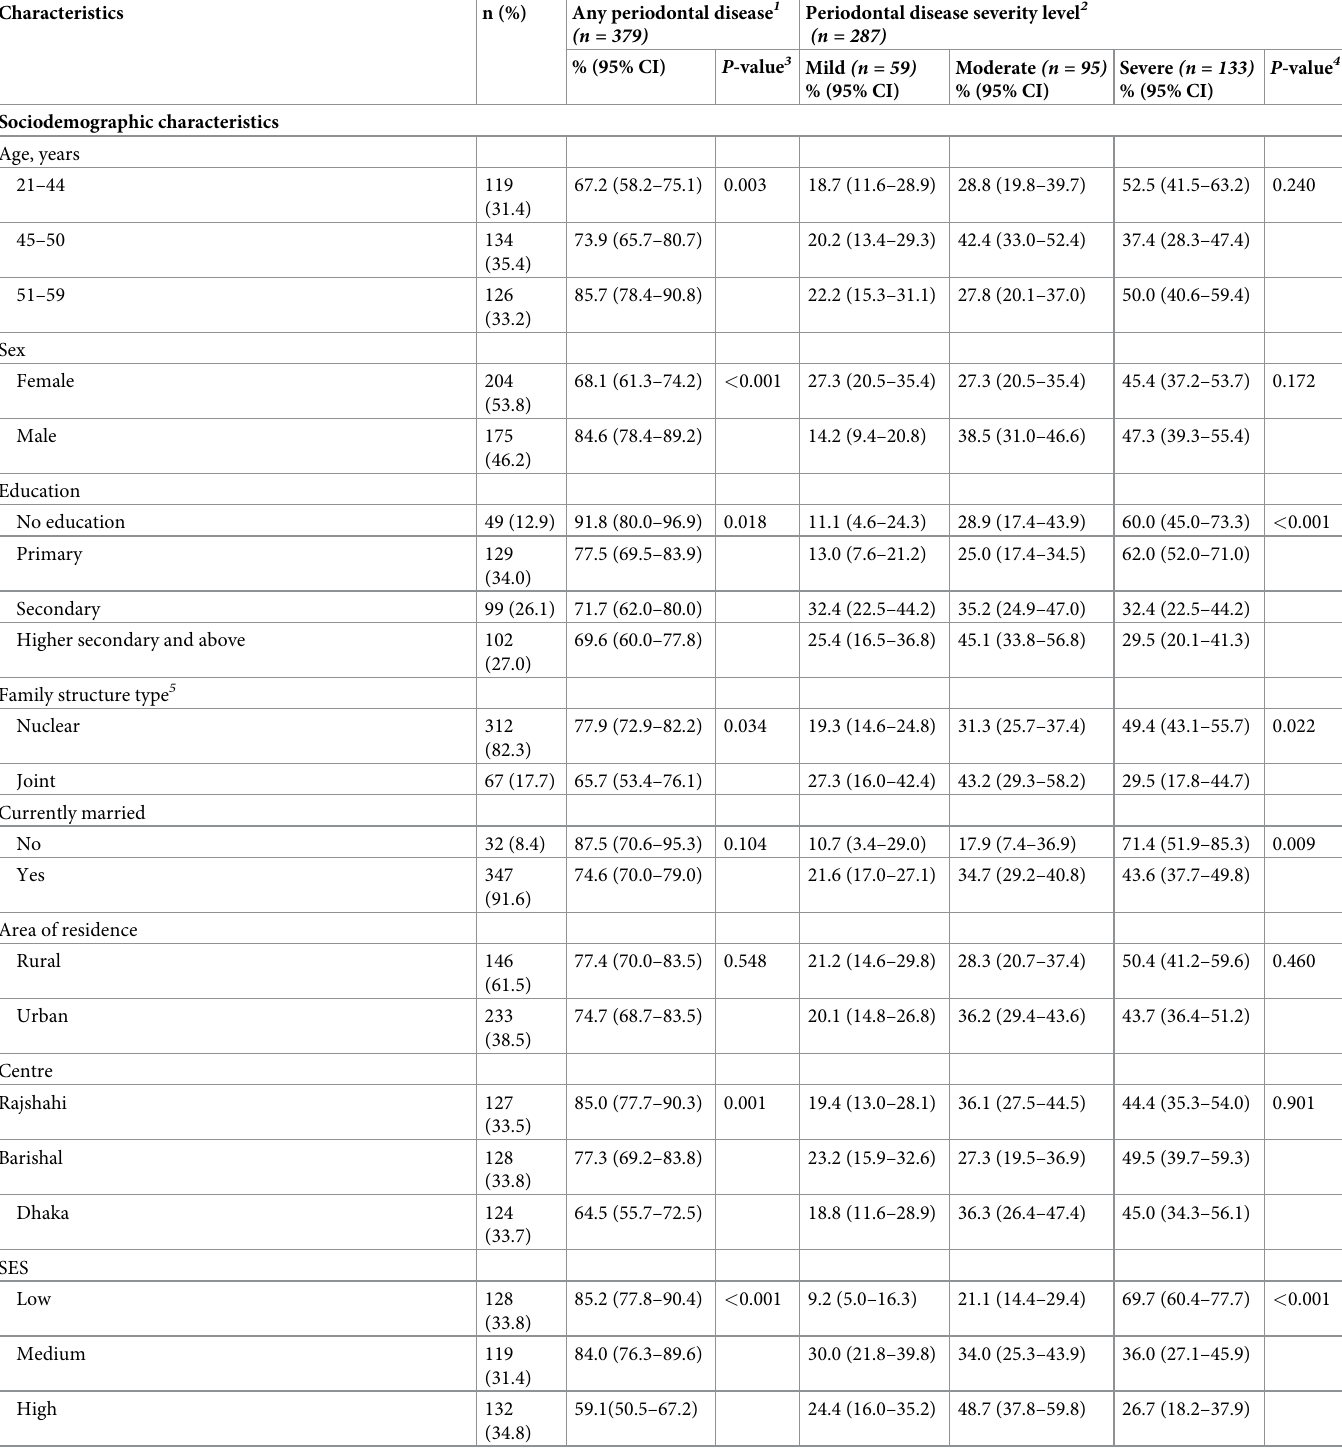
Table 1. Prevalence of any periodontal disease and its severity in type 2 diabetic patients according to sociodemographic characteristics, diabetes-related clinical determinants, self-care practices, and oral hygiene practices.